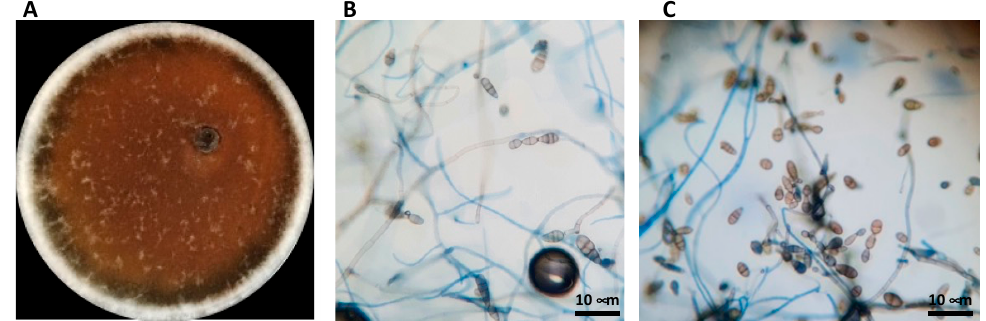
Figure 1. Morphological identification of Alternaria alternata. ( A ) A. alternata grown in PDA broth for 7 days at 28 °C. ( B , C ) Observations under phase-contrast light microscope magnification 60×.